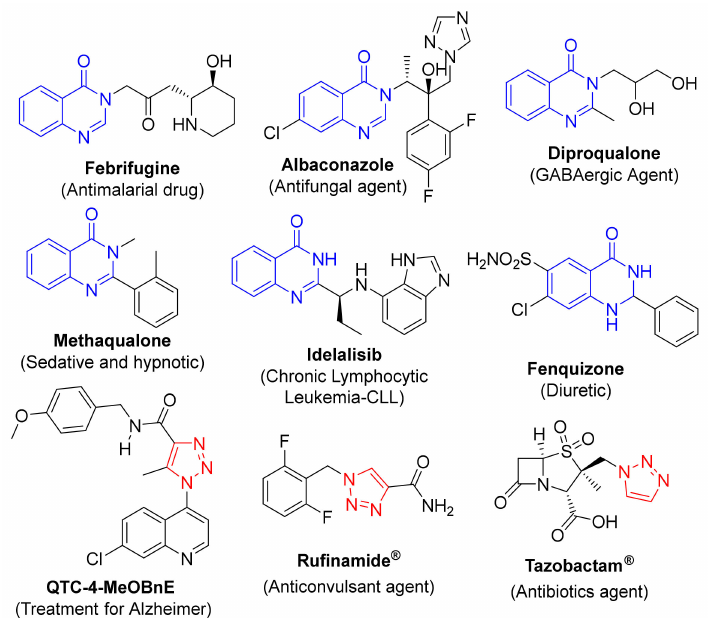
Figure 1. Quinazolinones and 1,2,3-triazoles with pharmacological activities.